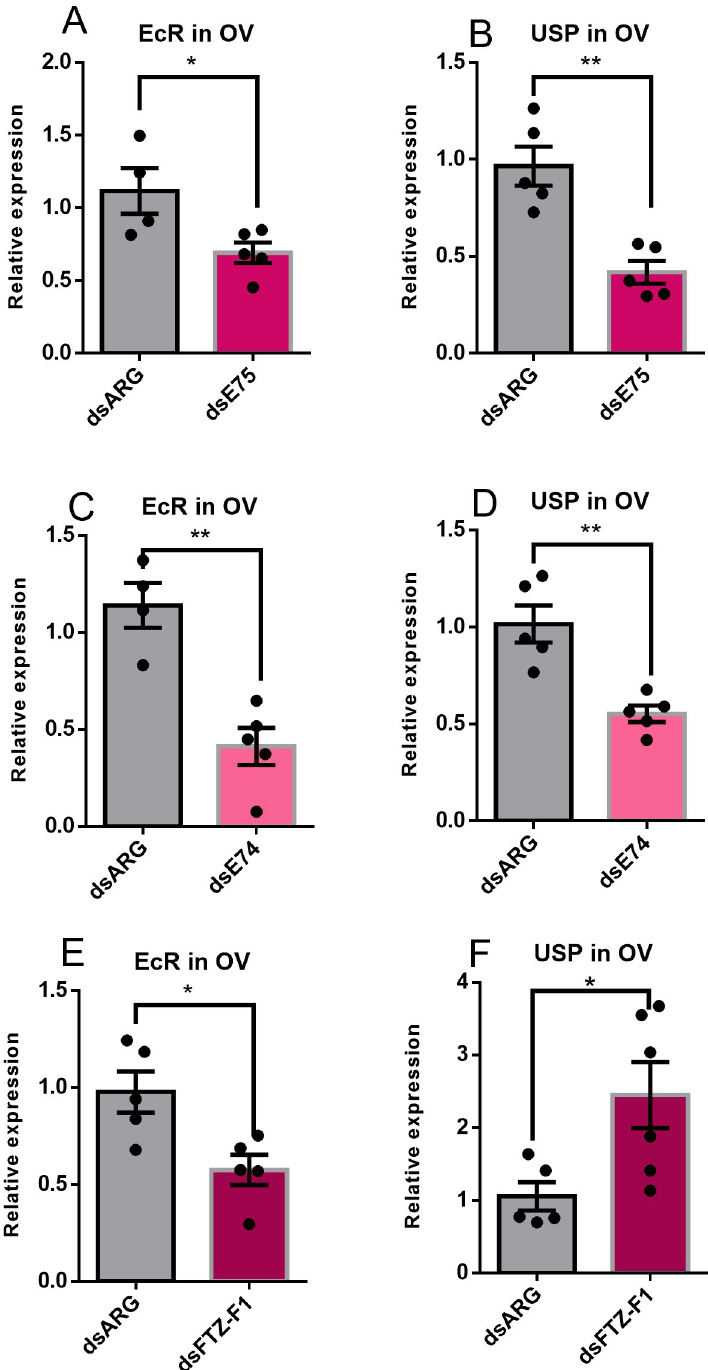
Fig 5. Effects of knockdown of E75 , E74 and FTZ-F1 on expression of the ecdysone receptor in the ovary of adult females 4 days post blood meal. Adult females were injected with dsRNA and fed on a blood meal as described in Materials and Methods. Relative transcript levels were measured using RT-qPCR and analyzed using the 2 − ΔΔ Ct method. Data are means ± SEM (n = 4–6). Rp49 and β -actin were used as reference genes. Statistical analysis was performed by Student’s t-test. � p < 0.05, �� p <